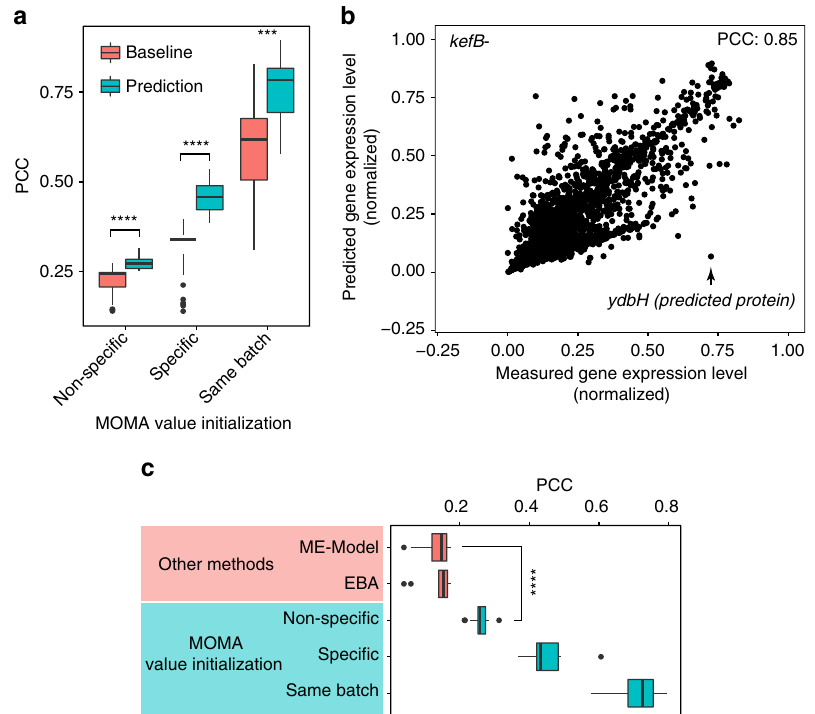
Figure 6 | Model validation for 16 novel knockouts in transcriptome prediction and performance comparison with other methods. ( a ) PCC between predicted and measured expressed levels of 4096 genes for 16 knockout conditions. Three expression value sets were used to initialize the recurrent neural network (RNN). Non-specific initialization corresponds to the case where the RNN was initialized with the values of the most frequent condition in Ecomics, MG1655 cells in M9/LB media ( P o 10 (cid:2) 10 ). Specific source initialization corresponds to the mean expression profile of BW25113 cells in M9/Glucose in the compendium, which is the same media and strain that was used in the knockouts ( P o 10 (cid:2) 7 ). Same-batch initialization corresponds to the mean expression genome-wide profiles of BW25113 cells in M9/Glucose that was measured in the same batch with the 16 knockouts ( P o 10 (cid:2) 3 ). ( b ) Scatter plot between predicted and measured expression levels for the kefB knockout condition. ( c ) Method comparison of prediction performance. We compared the prediction performance of transcriptome response to 16 KOs with ME-Model 26 ( P o 10 (cid:2) 6 for non-specific, P o 10 (cid:2) 13 for specific, P o 10 (cid:2) 16 for same-batch), and EBA 5 ( P o 10 (cid:2) 7 for non-specific, P o 10 (cid:2) 14 for specific, P o 10 (cid:2) 16 for same-batch). The error bar indicates standard error over the